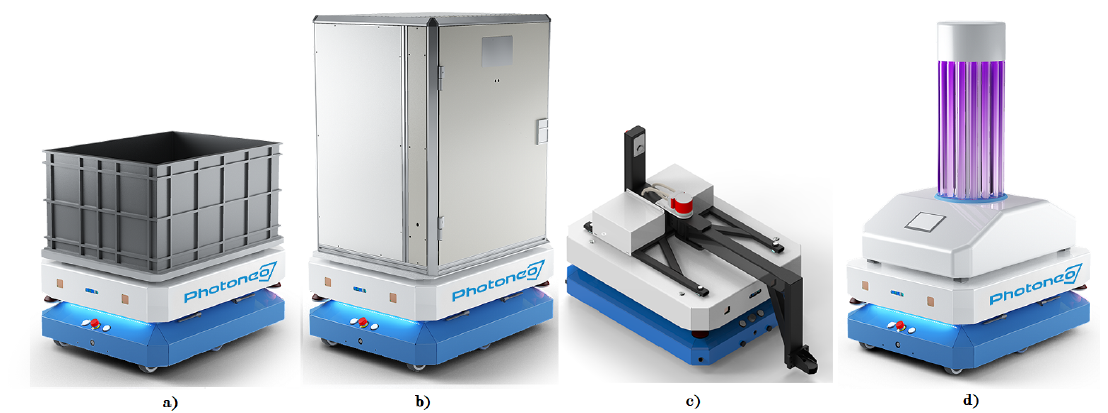
Figure 12. Various add-ons for Phollower: ( a ) simple transport, ( b ) locked box transport, ( c ) towing add-on, and ( d ) Phollower UV+ germicide